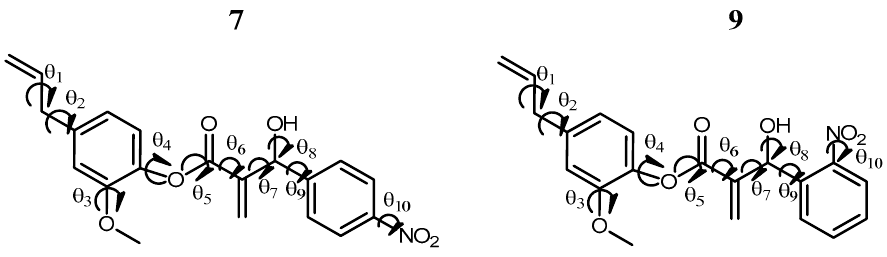
Figure 3. Computational methodology used to minimize the new hybrids 7 and 9 . Optimized geometries (Cartesian coordinates) to 7 and 9 are available in the Supplementary information.